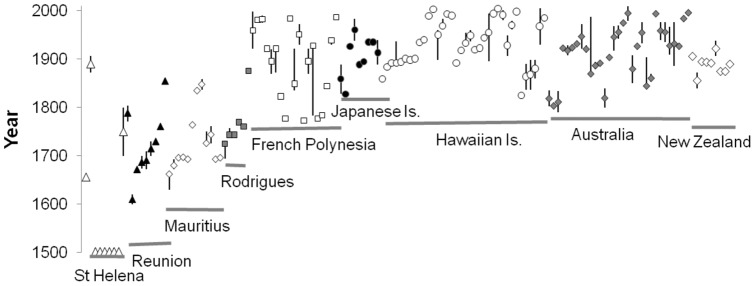
Date of ultrataxa extinctions (with vertical lines showing minimum and maximum estimate of date where available) for selected locations, compared with date of first settlement of >5
years by a continental or continental-island based nation (grey line).